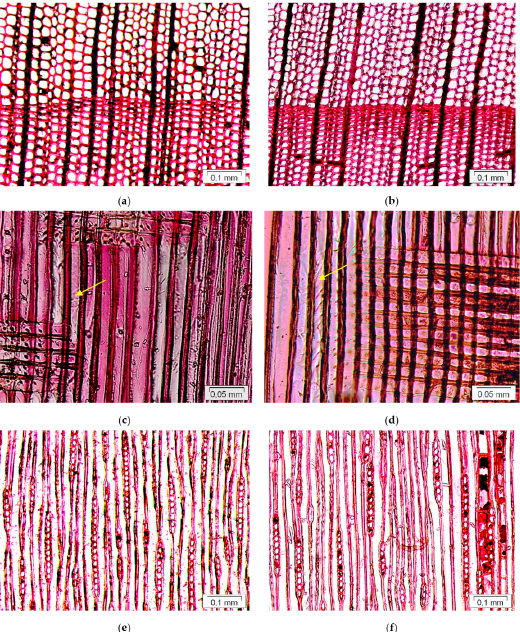
Figure 4. The microscopic structure of oriental arborvitae wood: ( a ) sapwood transverse section, ( b ) heartwood transverse section, ( c ) sapwood radial section, ( d ) heartwood radial section, ( e ) sap- wood tangential section, and ( f ) heartwood tangential